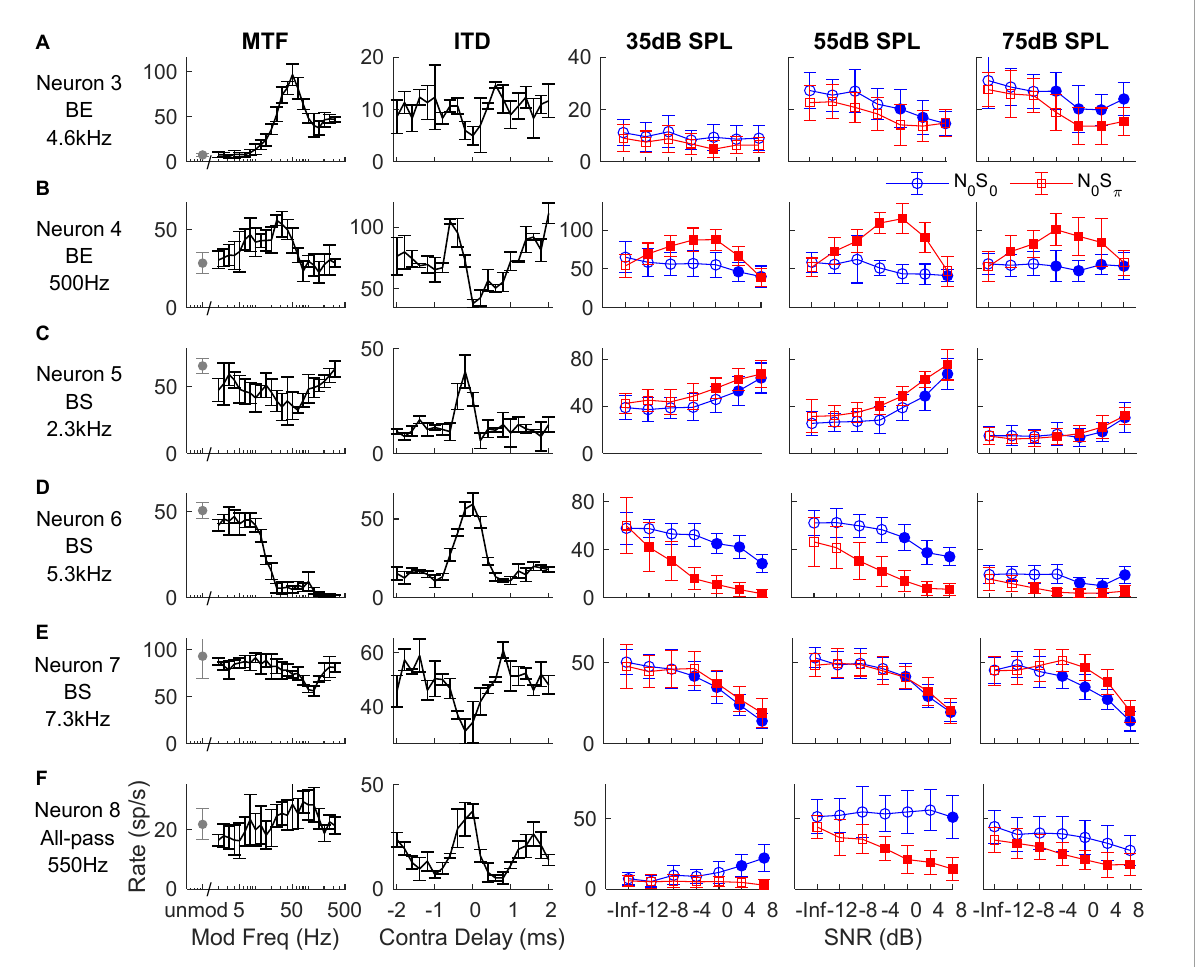
FIGURE4 Responses of six example neurons (A–F) . The left two columns show the neuron’s MTF and ITD sensitivity, respectively. The right three columns show the neuron’s response to N 0 S 0 (blue circles) and N 0 S π (red squares) TIN stimuli at noise levels of 35, 55, and 75 dB SPL, respectively; filled symbols indicate supra-threshold responses. MTF shape and tone frequency of TIN stimuli (close to CF) are shown on the